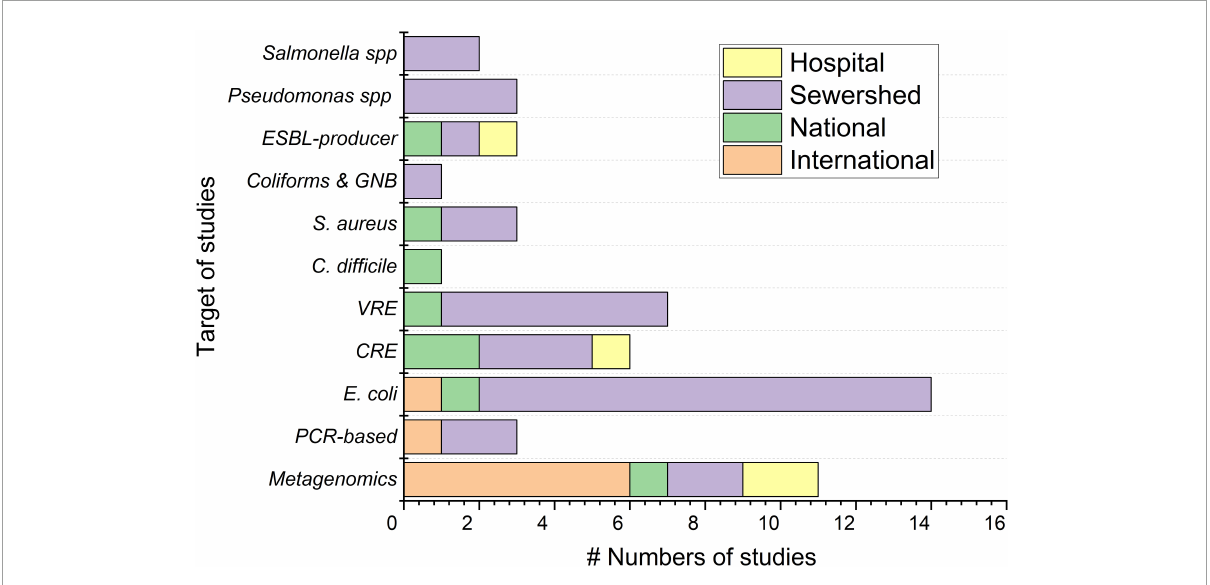
FIGURE3 Number of studies using different ARB targets. International, studies conducted in more than two countries (pooled intercontinental within international), National/Regional, studies conducted in more than one WWTP inside a country; Sewershed, studies conducted within a sewershed ; Hospital, studies conducted at the hospital level; CRE, carbapenem-resistant Enterobacteriaceae ; VRE, vancomycin-resistant enterococci, ESBL, extended-spectrum beta-lactamase; GNB, gram-negative